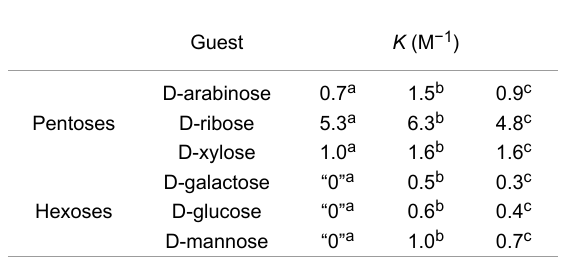
Table 4: Association constants for the sugar/ β -CD complexes ( K